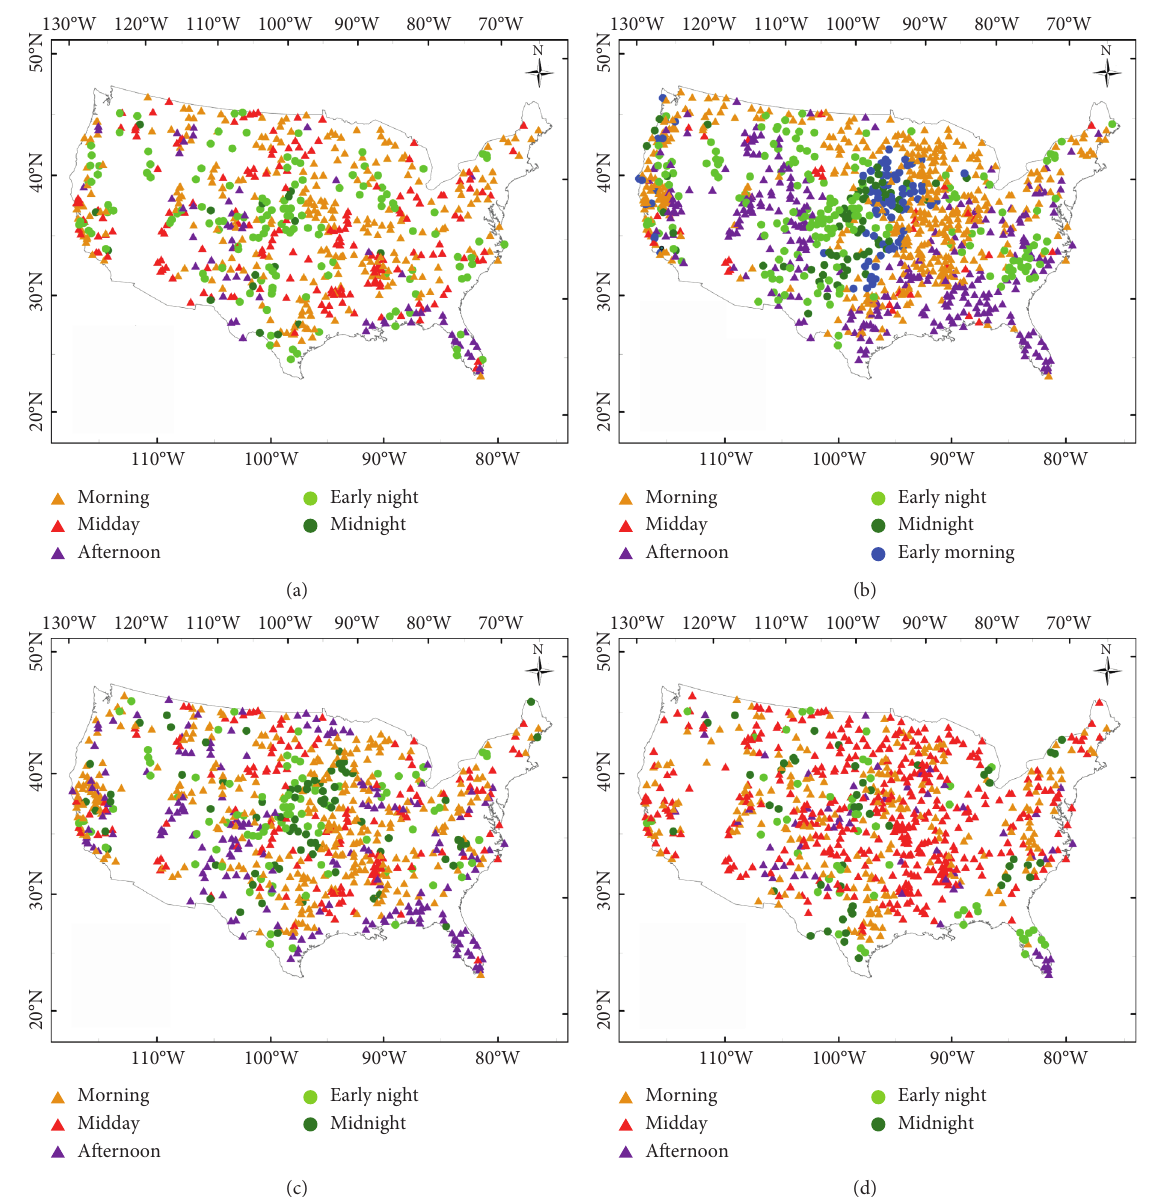
Figure 2: Stations with different diurnal variation of precipitation of gauge observations in different seasons: (a) for spring, (b) for summer, (c) for autumn, and (d) for winter. The triangle represents the diurnal variation with day peak, and the circle represents the diurnal variation with night peak. Table 1: The percent of different type of diurnal variation in Figure 2 (unit: %). No peak Morning Midday Afternoon Early- N Midnight Early- M Spring 47 22 0